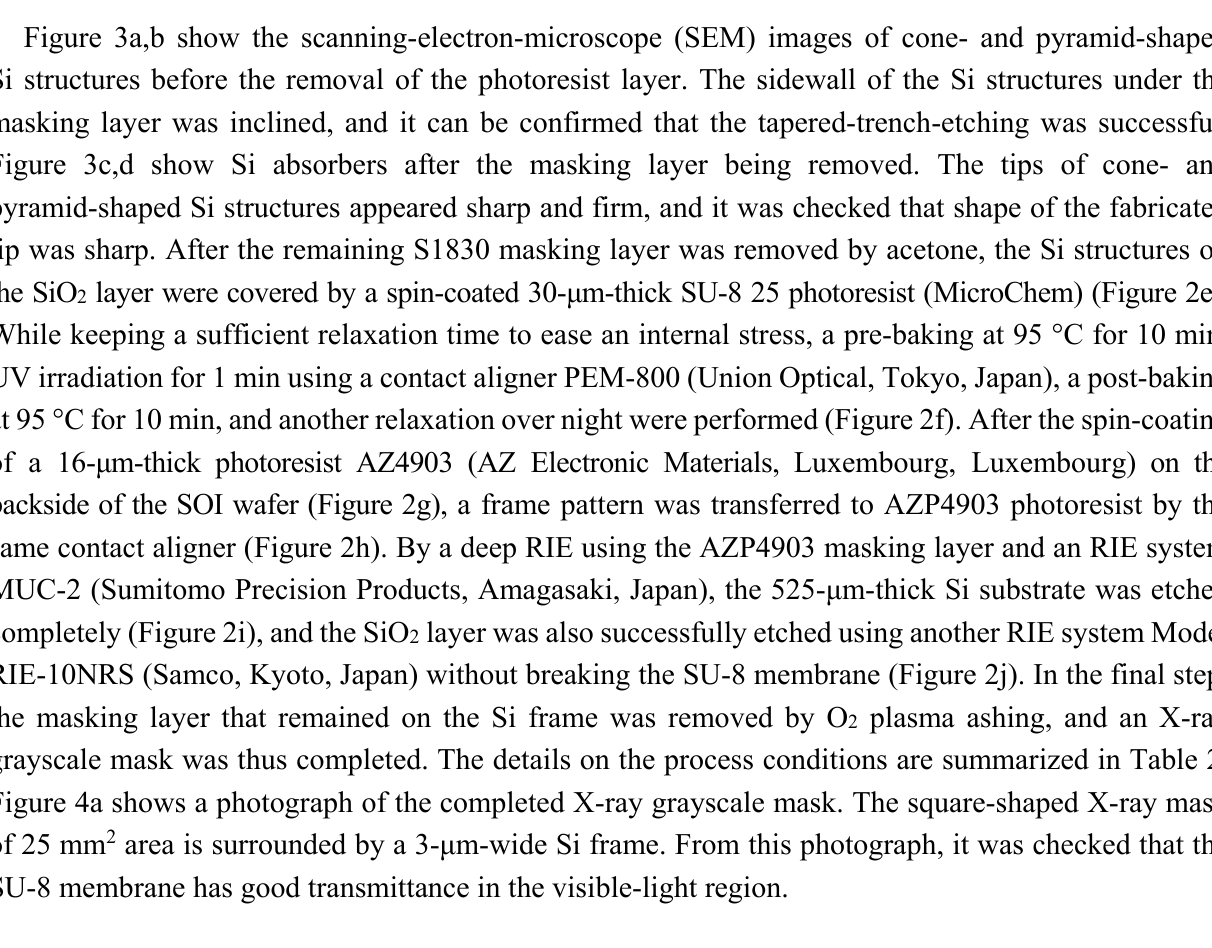
Figure 2. Process flow to fabricate X-ray mask composed with SU-8 membrane and Si absorber for grayscale lithography. Illustrations show the cross-sectional structure of the X-ray grayscale mask. ( a ) 1st spin-coating, ( b ) 1st UV exposure, ( c ) 1st development, ( d ) taper-RIE of Si, ( e ) removal of photoresist and 2nd spin-coating, ( f ) 2nd UV exposure and post-baking, ( g ) 3rd spin-coating, ( h ) 3rd UV exposure, ( i ) 2nd development and deep RIE of Si, ( j ) RIE of SiO 2